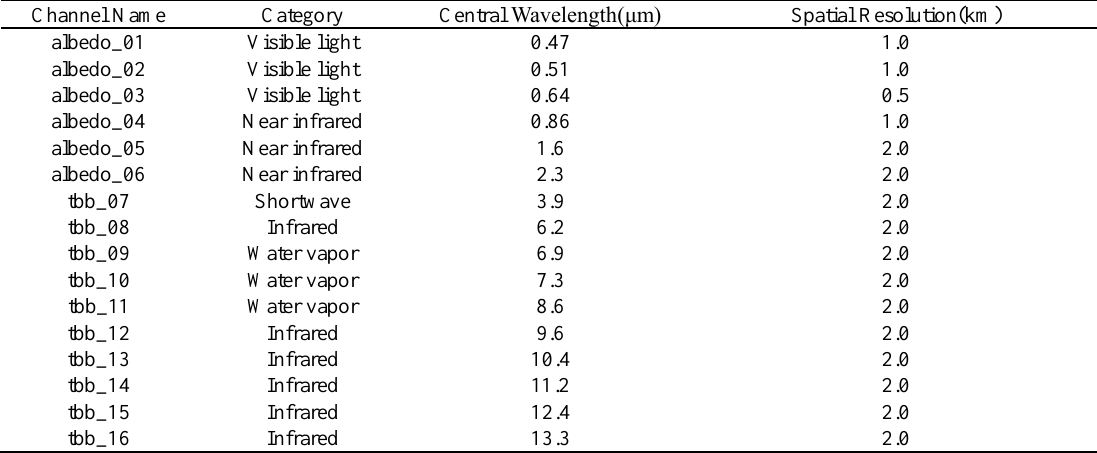
Table 1. Advanced Himawari Imager (AHI)